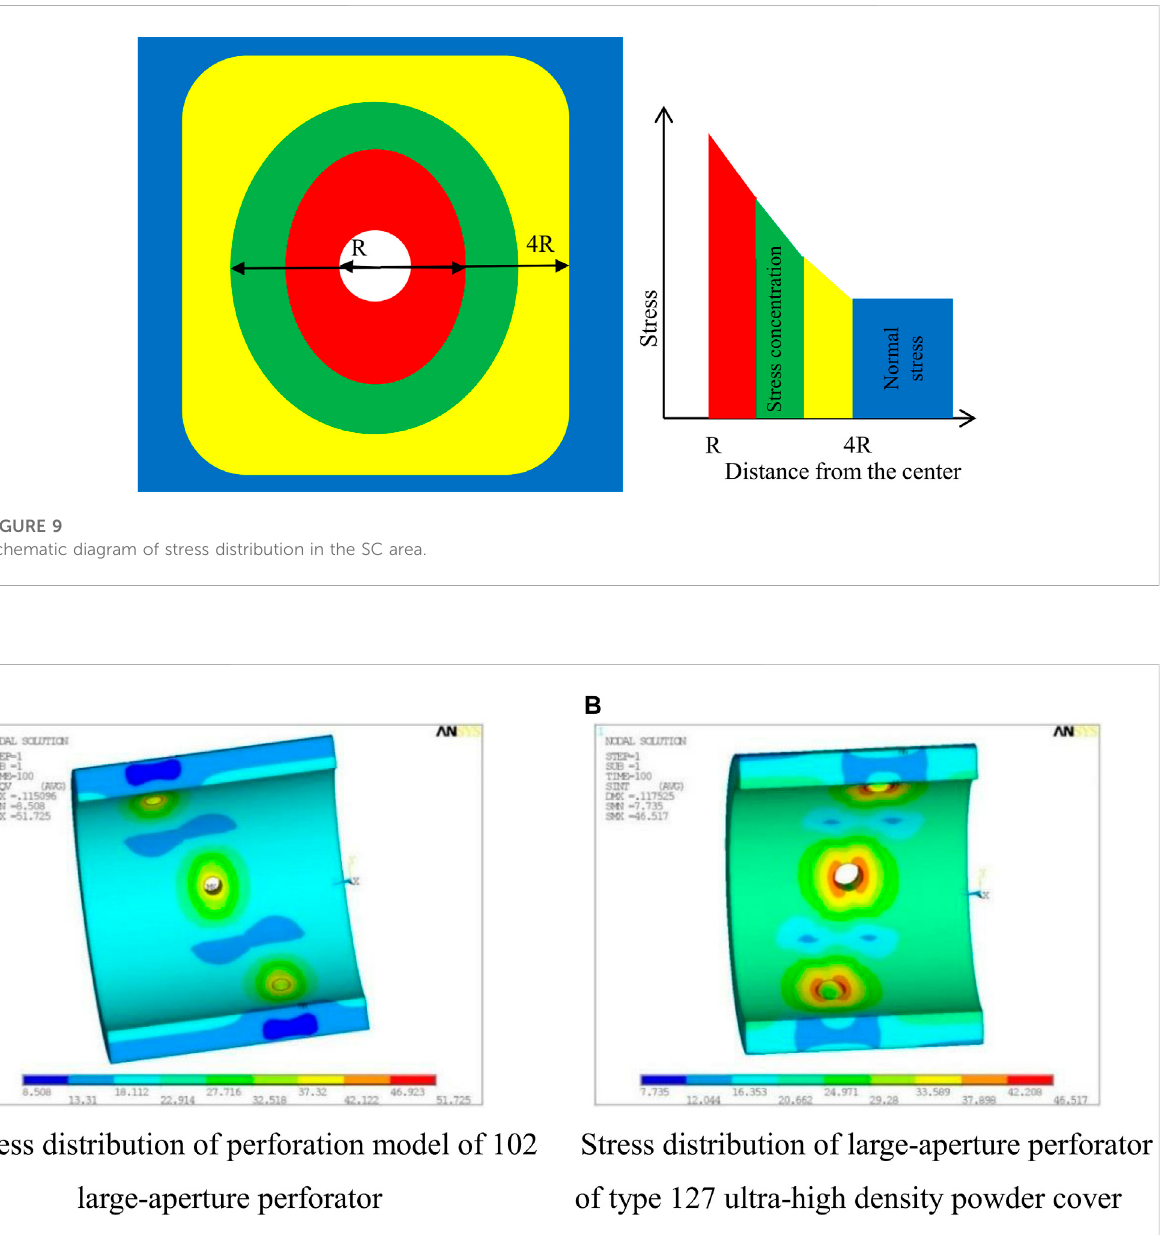
FIGURE 10 Stress distribution cloud diagram of cement sheath with different perforation models under fracturing conditions. (A) Stress distribution of perforation model of 102 large-aperture perforator. (B) Stress distribution of large-aperture perforator of type 127 ultra-high density powder